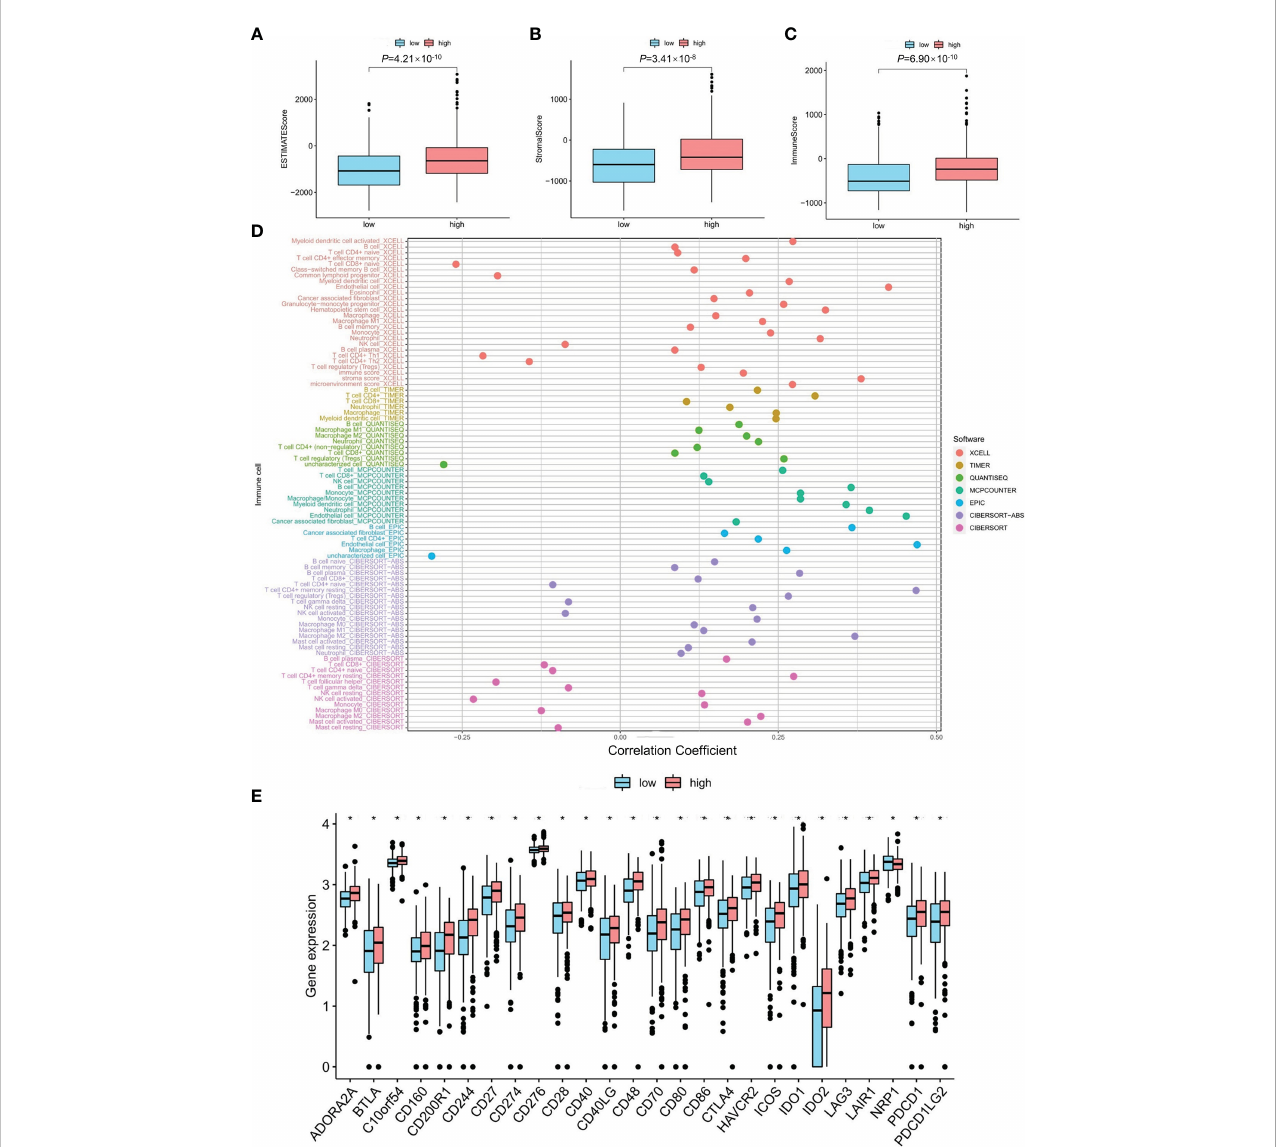
FIGURE 4 The investigation of tumor immune factors and immunotherapy. (A – C) The comparison of immune-related scores, estimate-related scores and stormal- related scores between low and high mRNA level of PDE1C . (D) The immune cell bubble between low- and high mRNA level of PDE1C . (E) The difference of 15 checkpoints expression between low- and high mRNA level of PDE1C . *P < 0.05